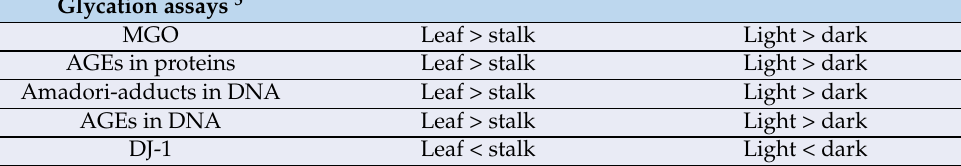
AGEs in DNA Leaf > stalk Light > dark DJ-1 Leaf < stalk Light < dark